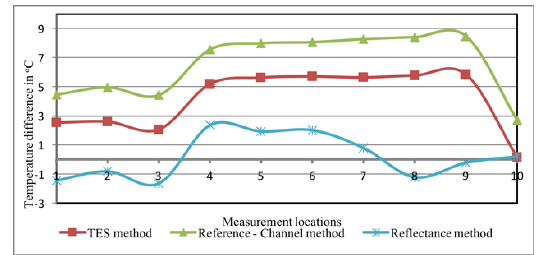
Figure 2. Temperatures measured using three different emissivity techniques. The measurement was carried out at two different surfaces during the image overpass time.